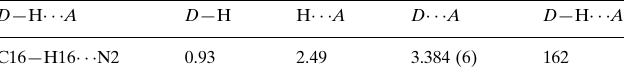
Hydrogen-bond geometry (A˚ , (cid:3)